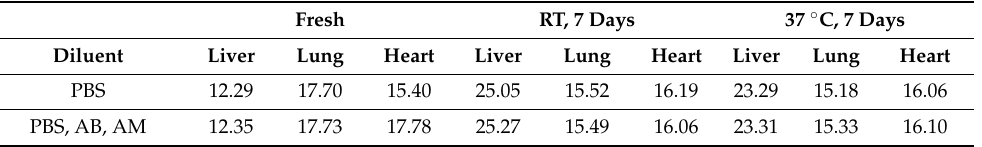
Table 2. Cq values obtained with the 18S rDNA qPCR using European rabbit tissues submitted to different conservation/preservation conditions.